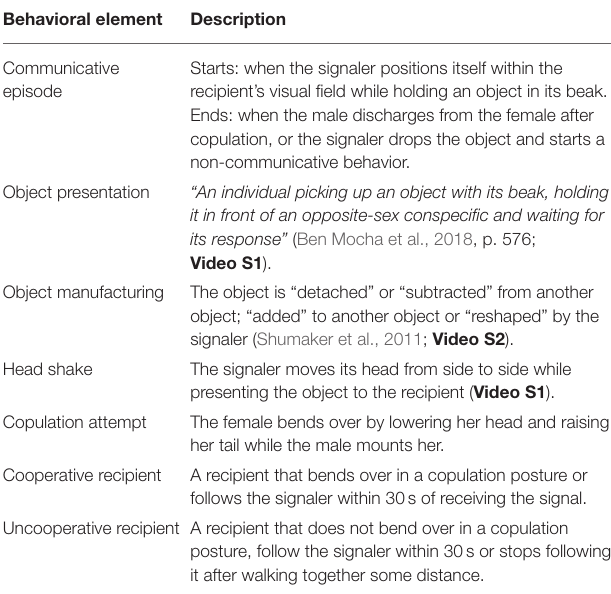
TABLE 1 | Ethogram of object